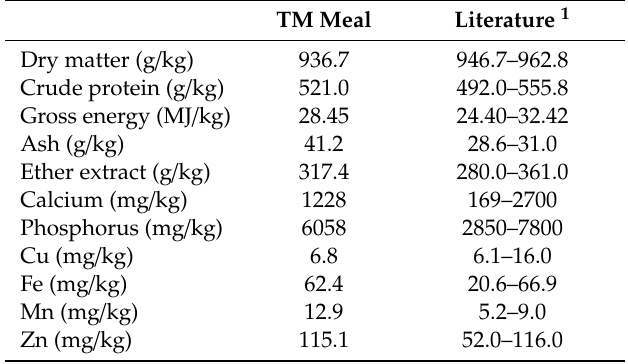
Table 2. Chemical composition and mineral content of T. molitor (TM) meal used in the study compared to range values in the literature (dry matter basis).